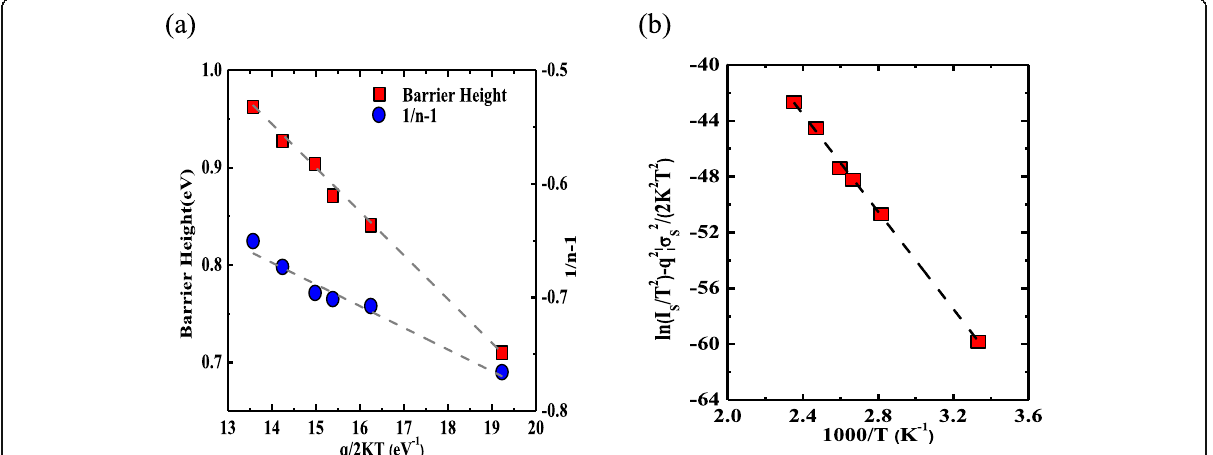
= 2 k 2 T 2 Þ versus s